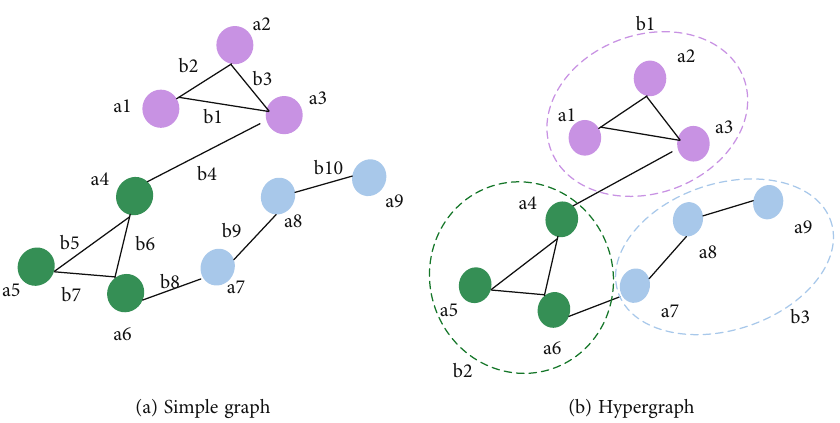
Figure 2: The di ff erence between a simple graph and a hypergraph.